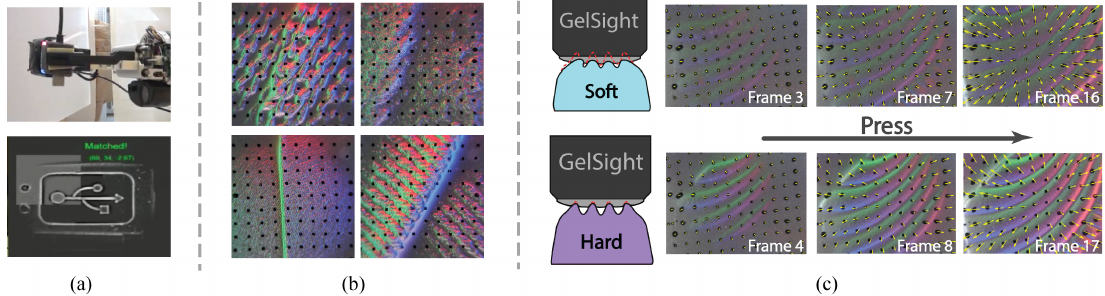
Figure 15. Examples of GelSight applications. ( a ) Li et al. [30] (Got copyright permission from IEEE): a robot inserts a USB cable into the socket, while GelSight image helps the robot to locate the in-hand position of the USG plug; ( b ) GelSight can differentiate difference fabrics from their textures (images are enhanced for display purpose). The shape of the foldings can also reveal other material information, such as the thickness, stiffness [36] (Got copyright permission from IEEE); ( c ) When pressing on a deformable object [37] (Got copyright permission from IEEE), the GelSight sequence can infer hardness information from the change of the object shapes and contact